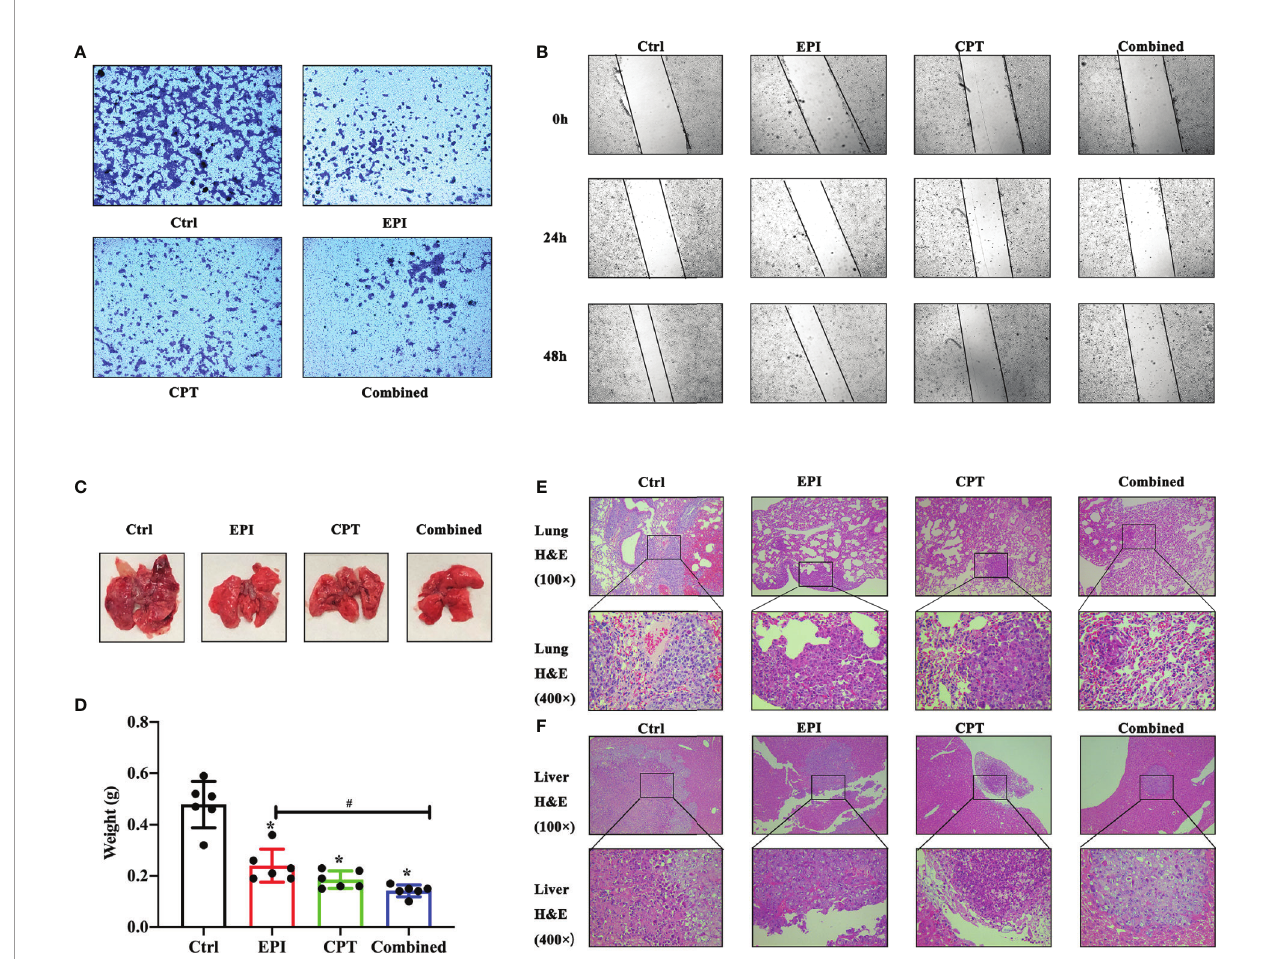
FIGURE 6 | The invasion and metastasis assay of HCC in vitro and in vivo . (A, B) The invasion and metastasis assay of Huh7 cells in vitro . (A) Transwell assay showed the migration of huh7 cells at 48 h. (B) In wound healing assay, migration of Huh7 cells was examined at 0, 24, and 48 h. (C – F) The invasion and metastasis assays of H22 cells in vivo was detected by lung metastasis assay 10 days after the fi rst drug injection. (C) The image of lung in mice model. (D) The assay of lung weight in mice model. (E, F) The H&E staining of lung (E) and liver (F) . *P < 0.05, # P <